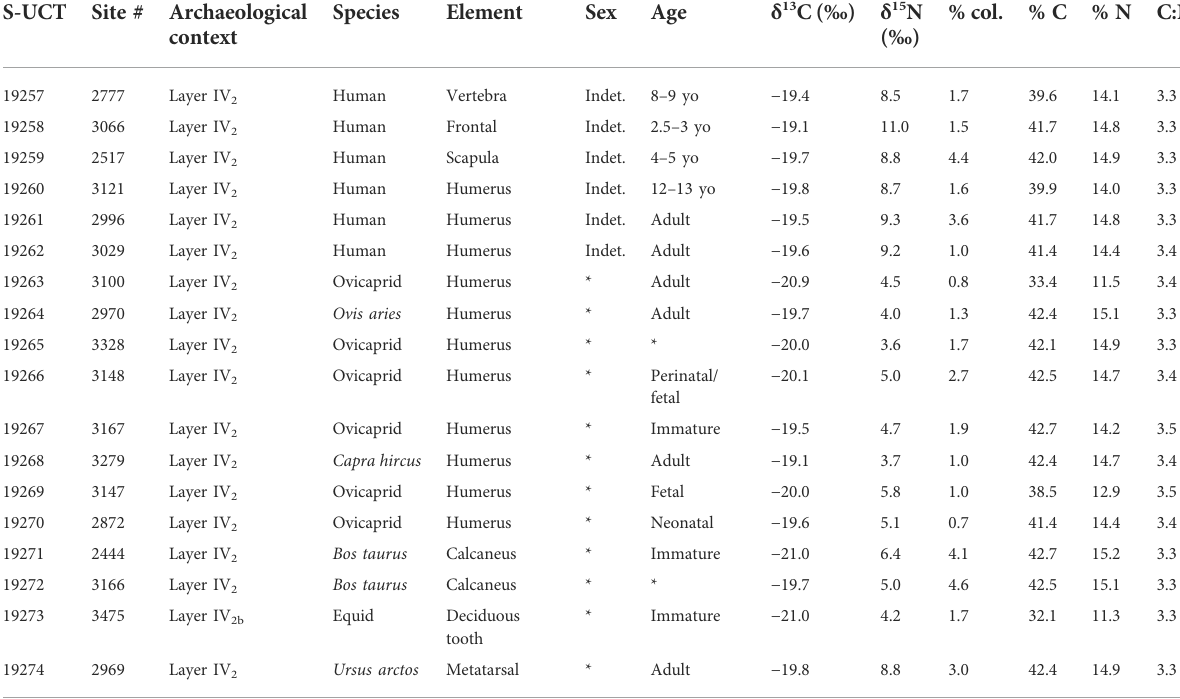
TABLE 1 Cova Bonica δ 13 C and δ 15 N values from fauna and humans, human sex and age, chronology, collagen control indicators (yield, % C, % N, and C:N), S-UCT number, sampled bone, and archaeological